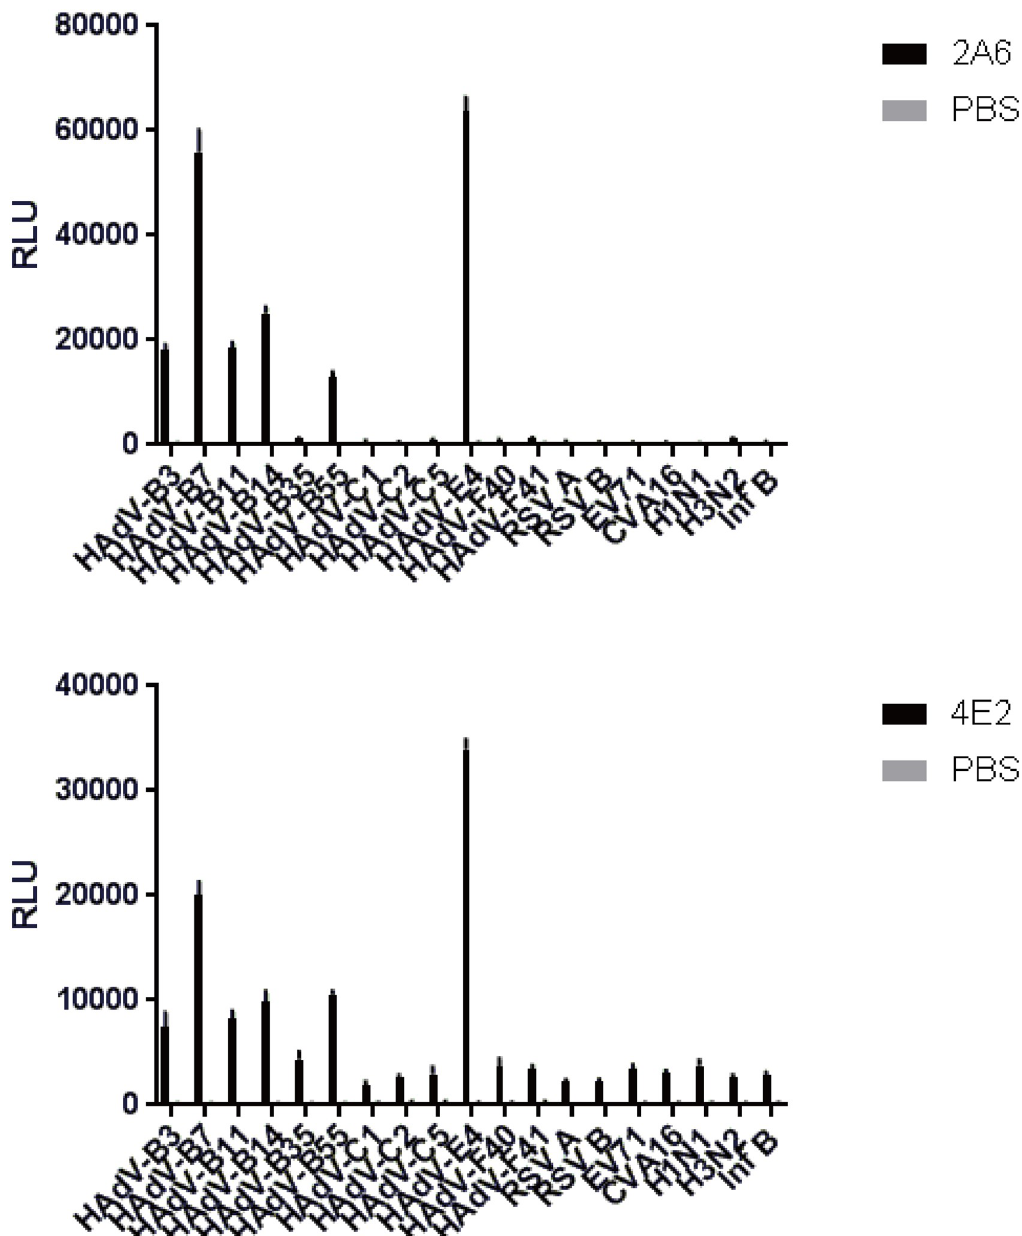
Fig 3. Measurement of virus-binding capacity of Fabs 2A6 and 4E2 using CLEIA. The virus-binding capacities of Fabs 2A6 and 4E2 were measured by separately binding to several types of HAdV, IFV, RSV, CVA16, and EV71. PBS was used as a blank control. The photons of light emitted were measured as RLU. Each virus was tested in duplicate, and the results represent the mean ± SD of three measurements. The average RLU of Fab 2A6 that reacted with HAdV-B35 was higher than those of the Fab that reacted with IFV, RSV, CVA16, and EV71. A similar result was found with Fab